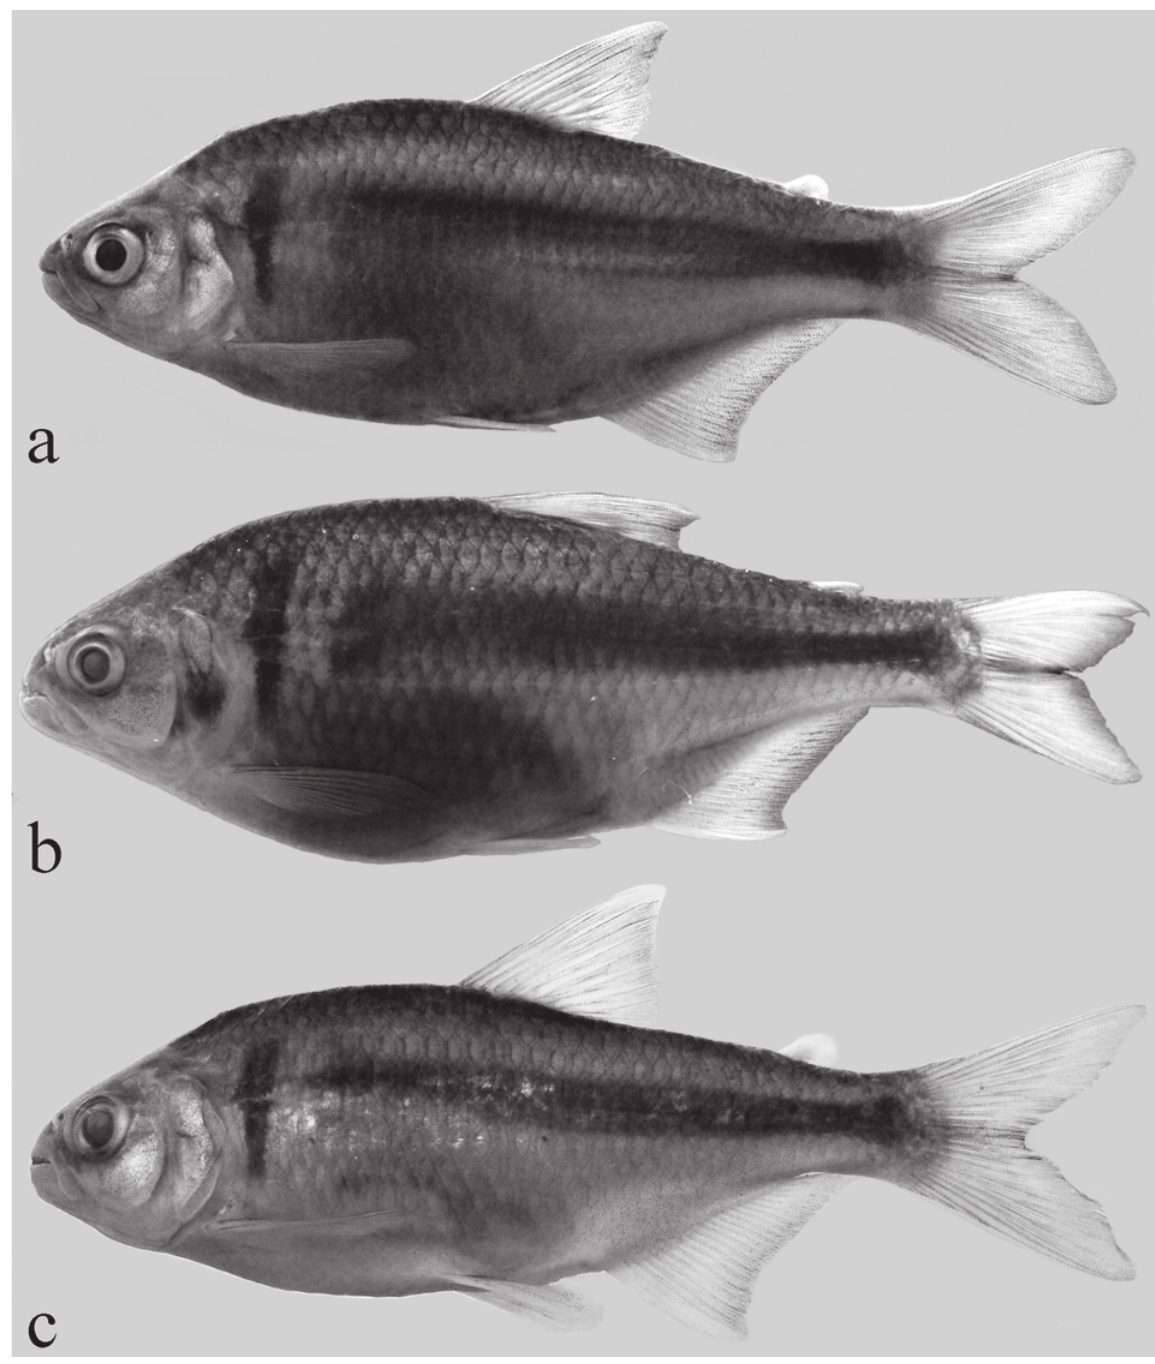
Fig. 4. Astyanax gymnodontus , (a) “ Astyanax sp. F” morphotype NUP 4122, 92.3 mm SL, Salto Santiago Reservoir; (b) “ Psalidodon sp.” morphotype NUP 3707, 110.6 mm SL, Jordão Reservoir; and (c) “ P . gymnodontus ” morphotype NUP 4062, 91.0 mm SL, rio